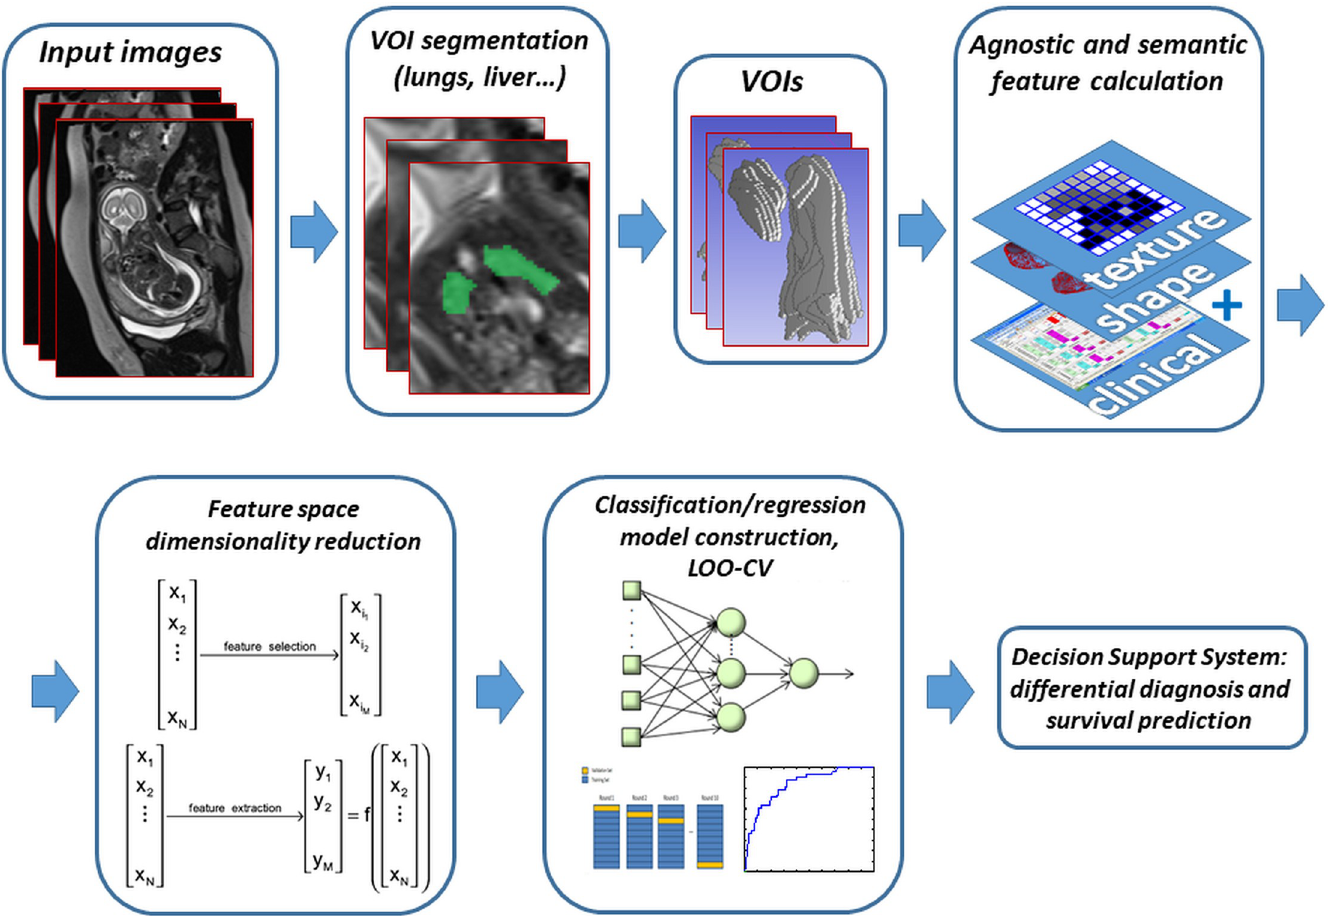
Fig 8. Machine learning pipeline. The flowchart illustrates the radiomics workflow starting from multimodal image acquisition. After manual or (semi)automatic segmentation/contouring of the volumes of interest (such as fetus lungs and liver), feature descriptors are calculated from VOI shape and texture. Together with a choice of prenatal clinical parameters, the obtained feature vectors are labeled with relevant output variables (e.g., presence of postnatal PH, or need for ECMO ... ) and, after dimensionality reduction performed to get rid of redundant and useless descriptors, enter the supervised classification/regression model-construction step, here represented by one of the possible choices, i.e., a multi-layer perceptron artificial neural network. Because of the relatively low number of samples, model training and validation will be obtained by leave-one-out cross-validation (LOO-CV), and various methods, such as the ROC curve, will quantify model quality. The trained and validated ML model will be the pipeline output to be employed in the Decision Support